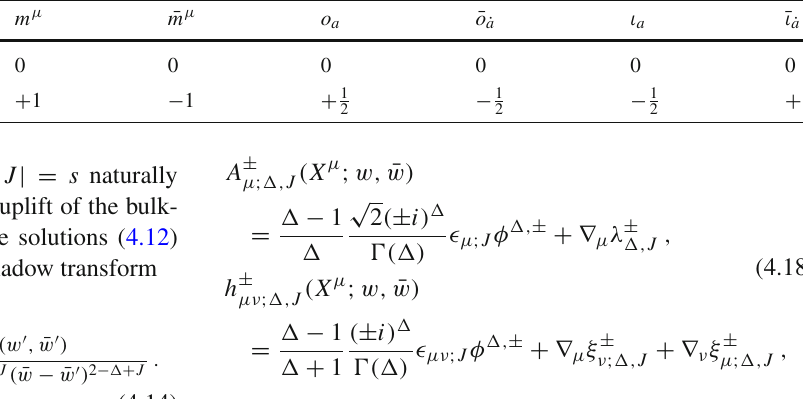
Table 1 SL ( 2 , C ) quantum numbers for elements of our tetrad and spin